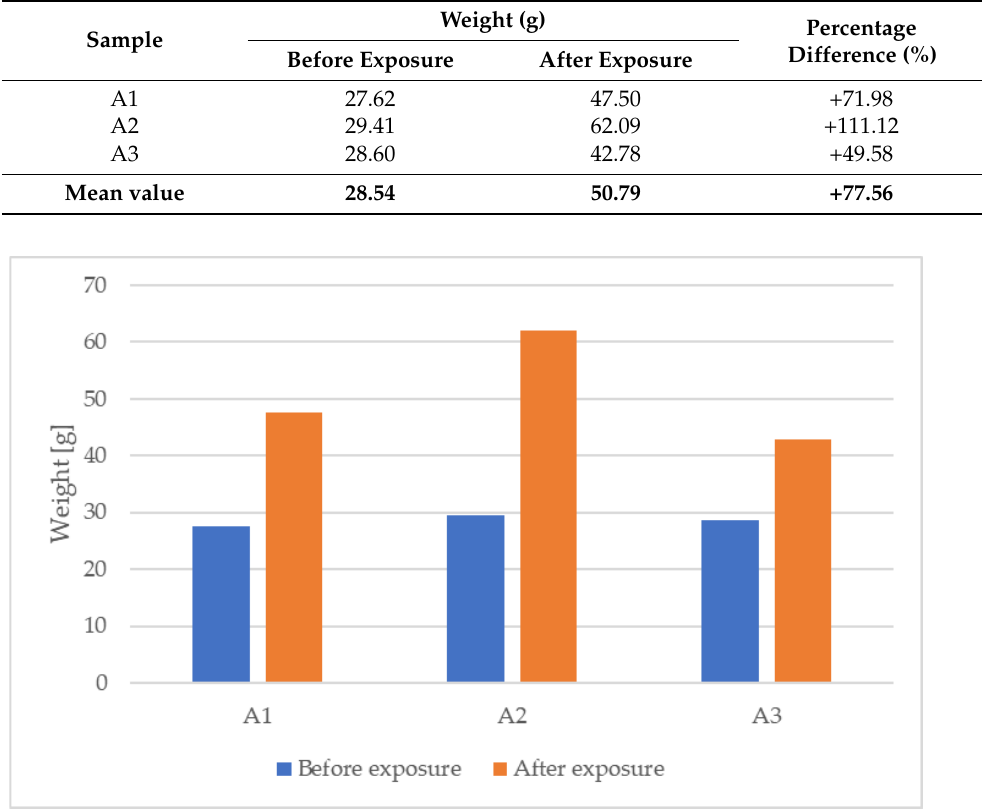
Figure 4. Graphic representation of weight variation.